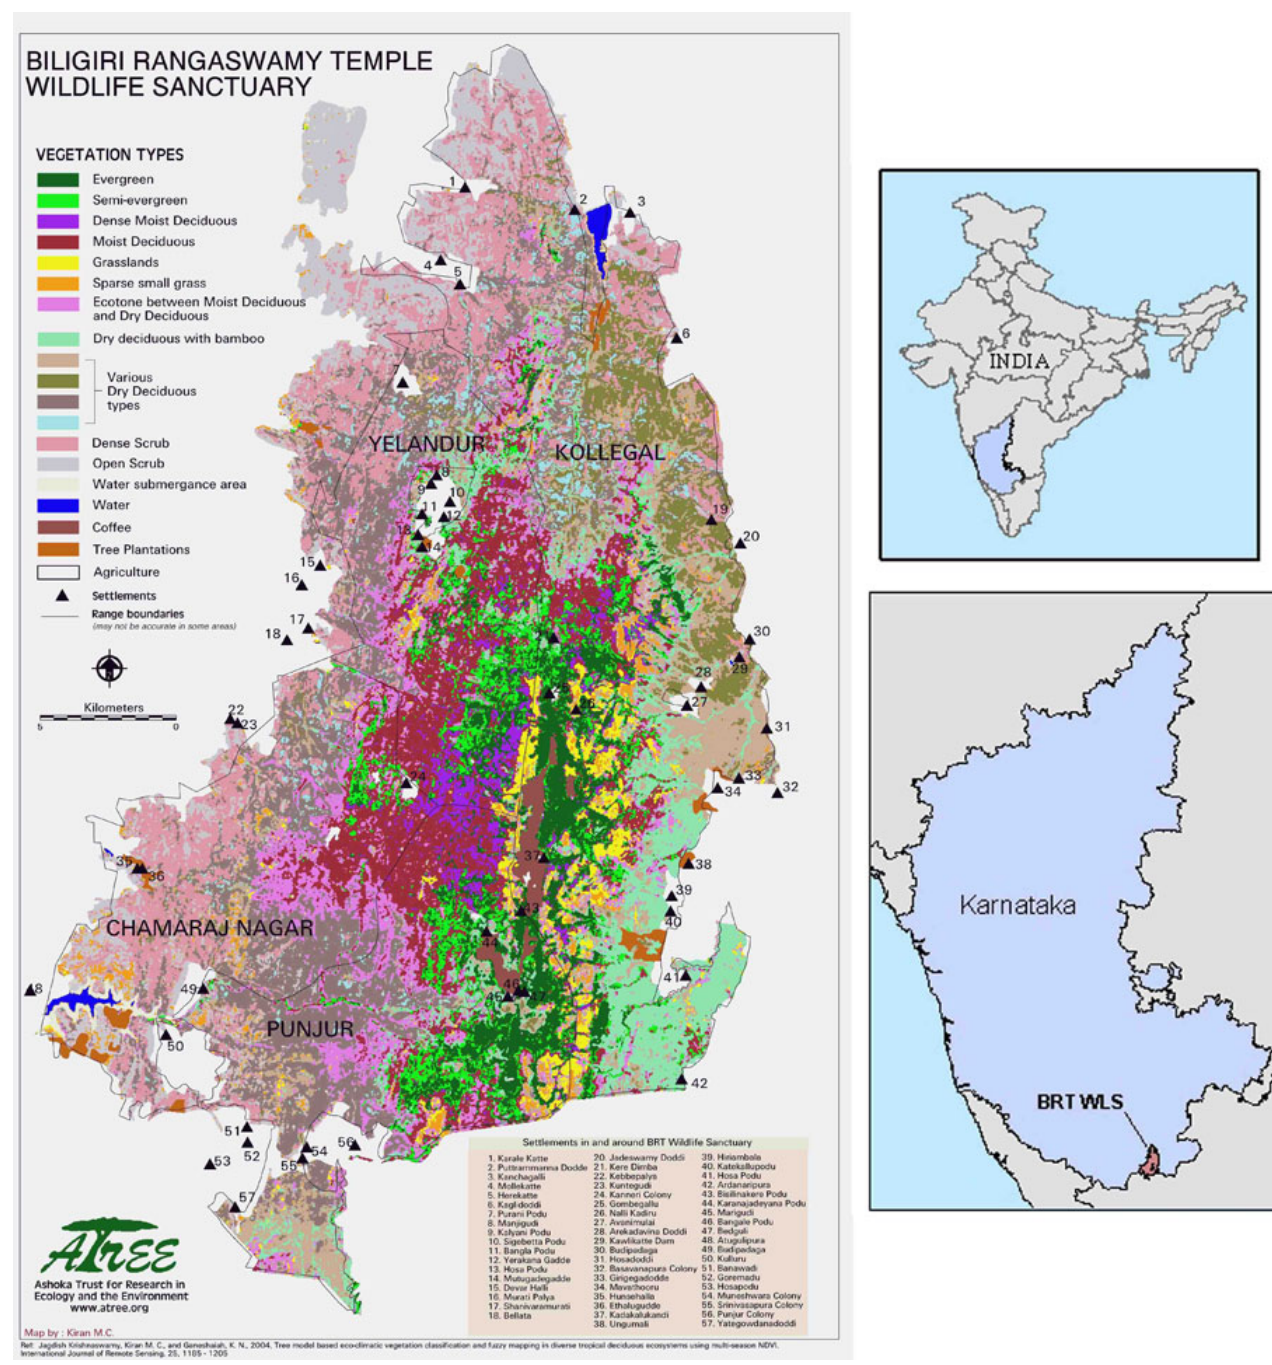
Fig. 1 . Locator map of study site and tribal